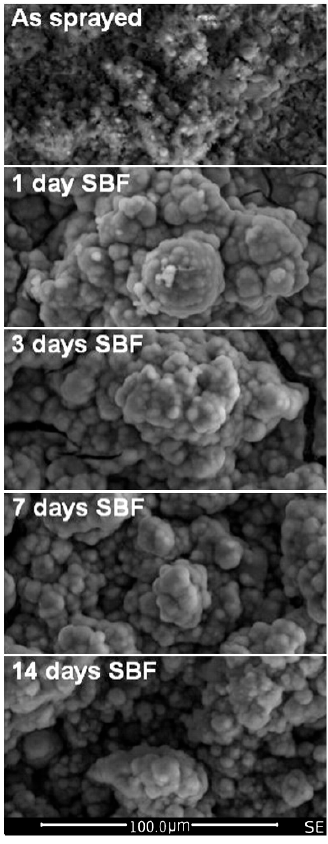
Figure 4. Surface evolution of the samples (BGCa3) immersed in SBF for increasing times, from Cattini et al., 2013 [98].